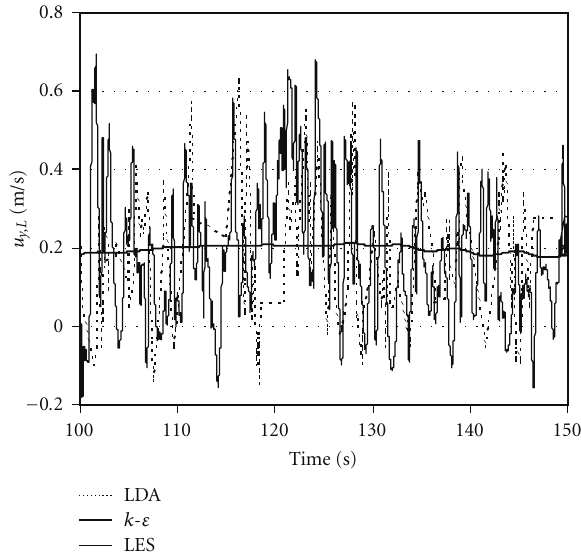
Figure 3: Time history of the axial liquid velocity at the centreline of the column, at a height of 0.25 m (from Deen et al.